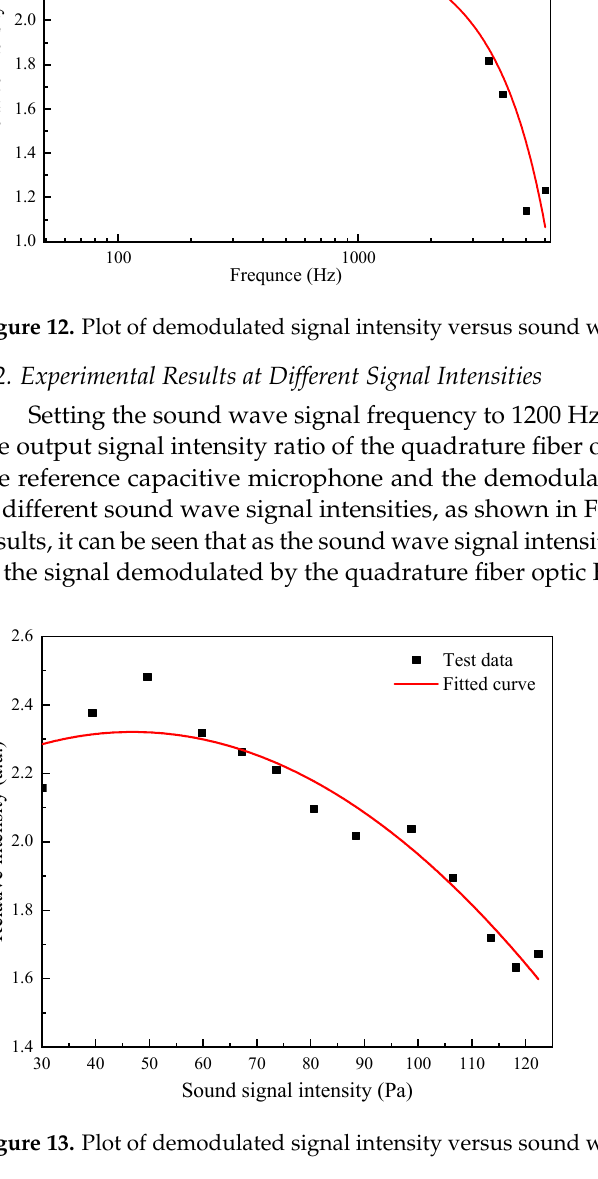
Figure 14. Plot of demodulated signal intensity versus data sampling rate. 6.4. Results of the Suppression of the Quadrature Phase Deviation by Fiber Step Height To investigate the suppression of the quadrature phase deviation caused by the laser wavelength drift, three Q–FFPM–DCM probes with fiber step heights of 4.82 μ m, 19.70 μ m, and 31.93 μ m were fabricated and adjusted to the quadrature state before the experiment. The output wavelength of the tunable laser was adjusted in steps of 0.4 nm to take each of the three probes out of quadrature in order to increase the quadrature phase deviation. From the experimental results shown in Figure 15, the Q–FFPM–DCM had the highest